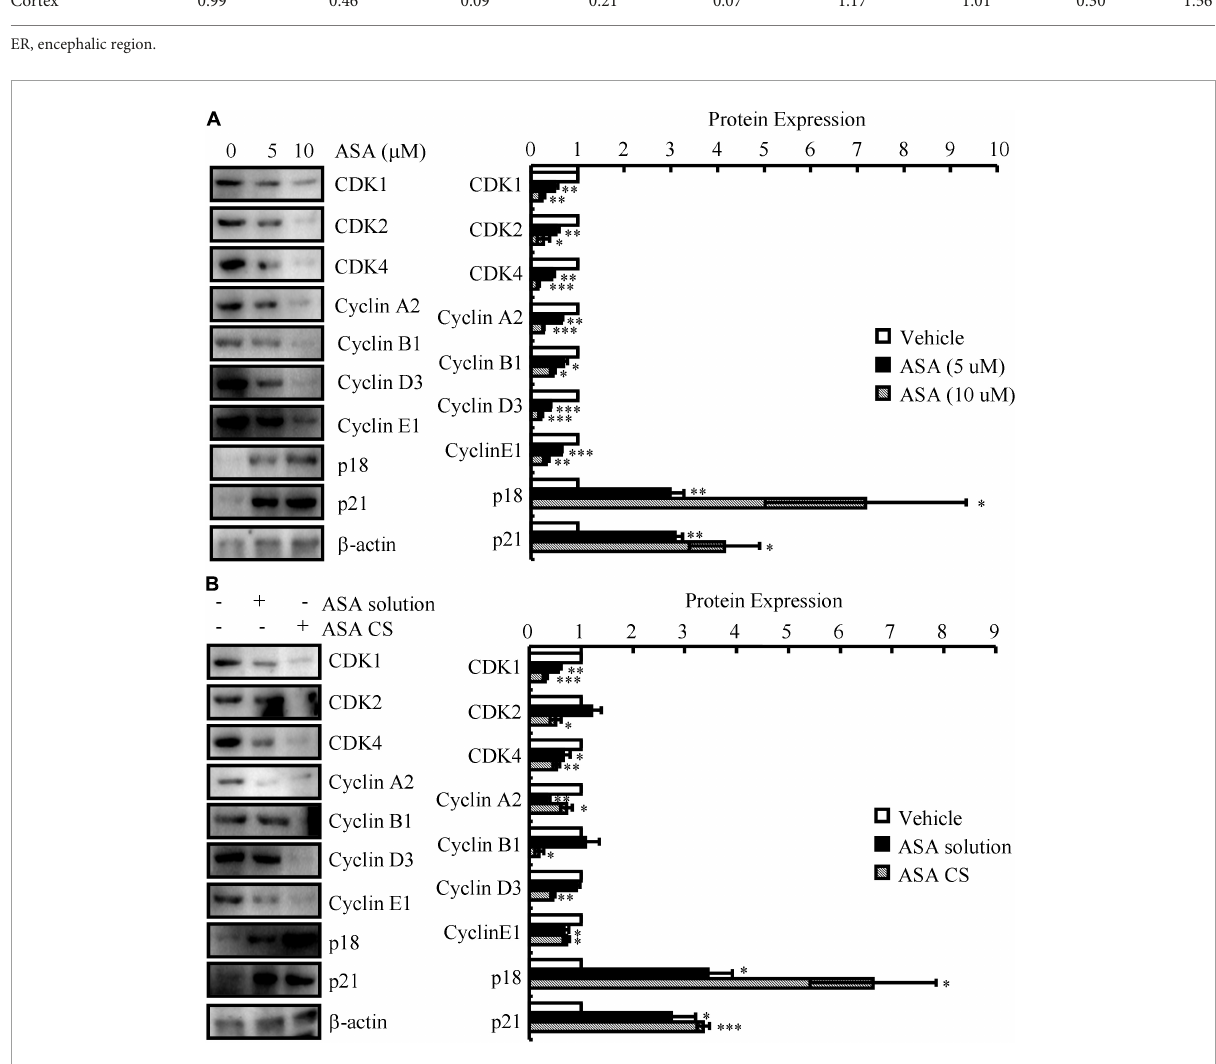
FIGURE3 ASA-CS showed better effects on restoring the expression of cell cycle-regulated genes than that of ASA solution. (A) N2a cells were treated with 5 or 10 µ M ASA. (B) ASA-CS and ASA solutions were intranasally administered to APP/PS1 Tg mice. (A,B) The total protein was extracted from the cells and brains. Western blotting was employed to detect the expression of CDK1/2/4, cyclin A2/B1/D3/E1, p18 and p21. β -actin served as an internal control. The optical density of the bands was analyzed using ImageJ software. Data are presented as the means ± S.E. of